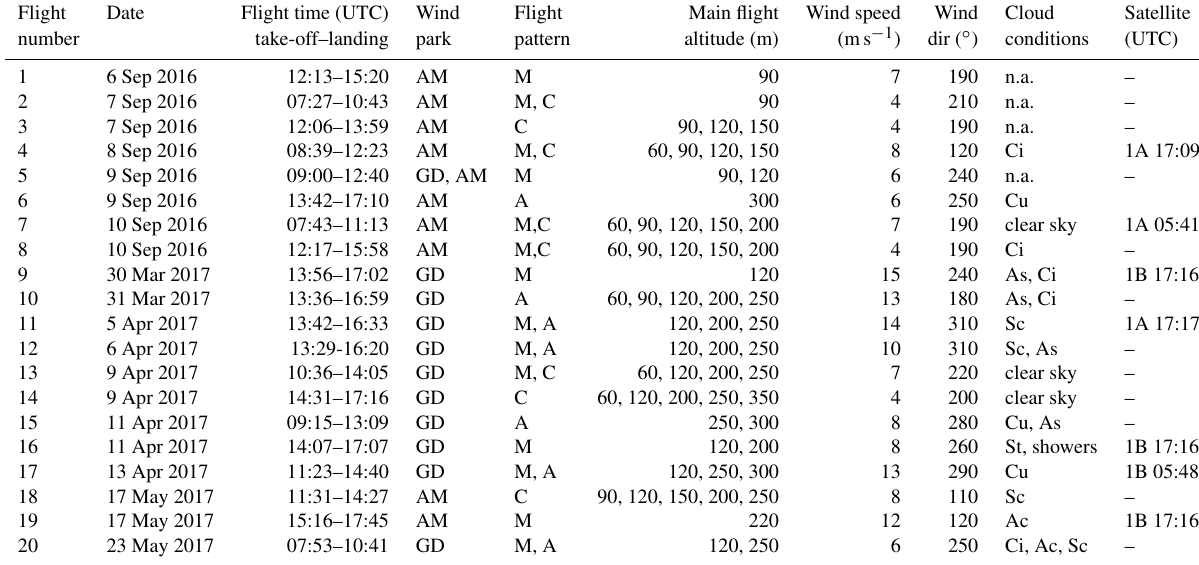
Table 1. Overview of the WIPAFF measurement flights 1–20. The flight patterns are MEANDER (M), CROSS (C) or ABOVE (A) as indicated in Sect. 4. The wind parks are Godewind (GD) or Amrumbank West (AM). Information on cloud conditions is not always available (n.a.). Sentinel 1A and 1B satellite overpasses on the same day are indicated as well. Cloud classification was done based on the visual impression: cumulus (Cu), stratocumulus (Sc), altocumulus (Ac), cirrus (Ci), and stratus